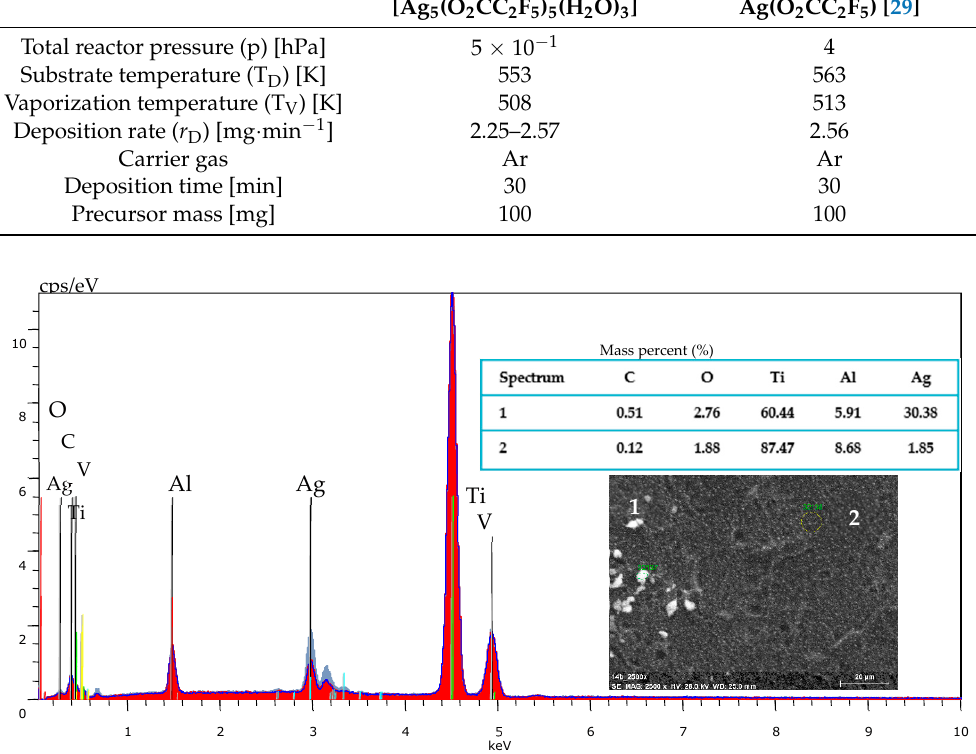
Figure 3. Energy Dispersive Spectroscopy (EDS) spectrum of Ti6Al4V/AgNPs sample and quantitative data.